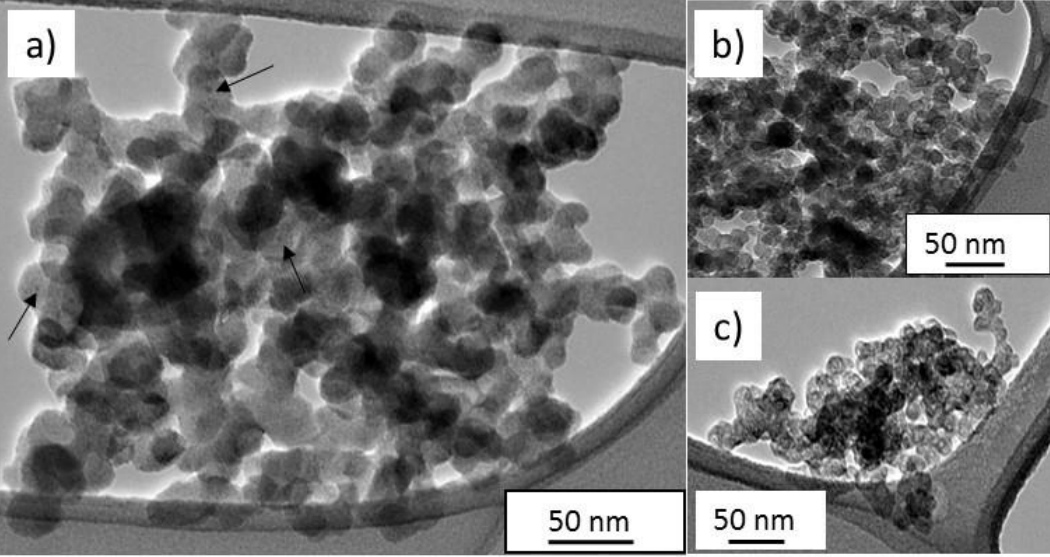
Figure 3. Transmission electron microscopy recorded on the as-formed ( a ), argon ( b ), and ammonia ( c ) thermally-treated materials.